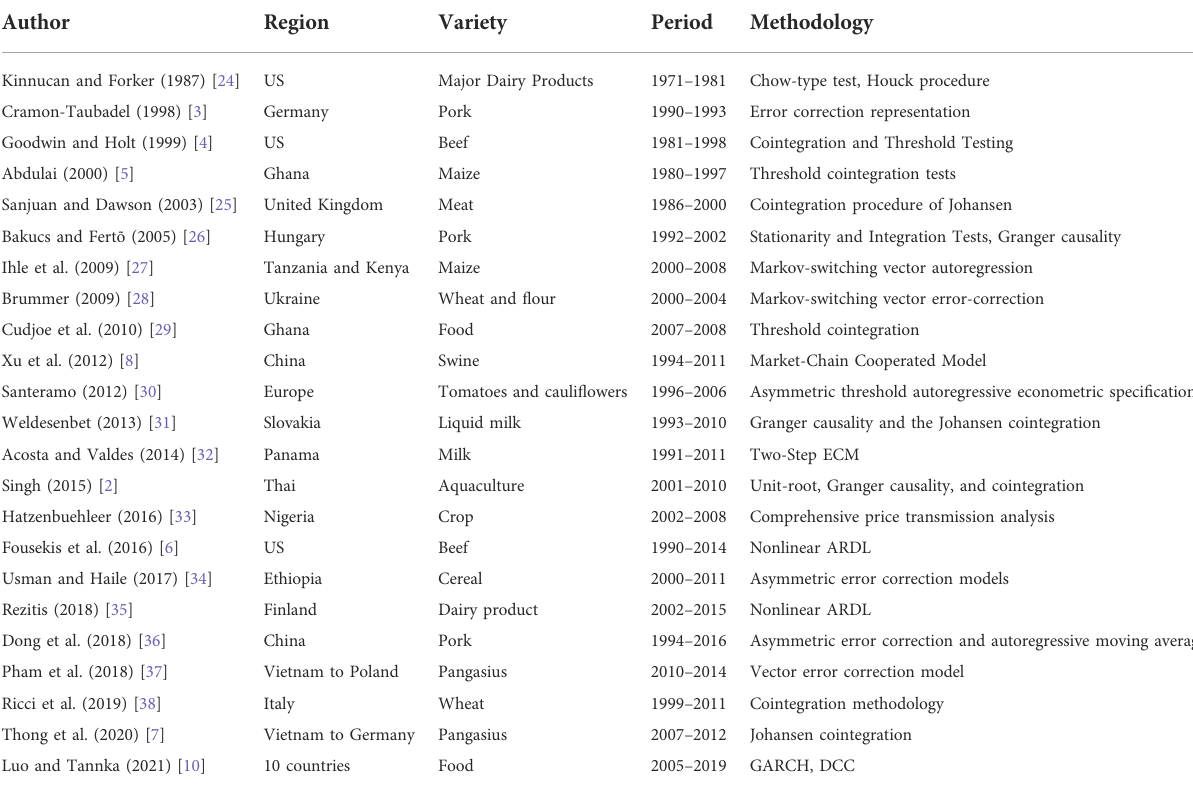
TABLE 1 Literature review of price transmission